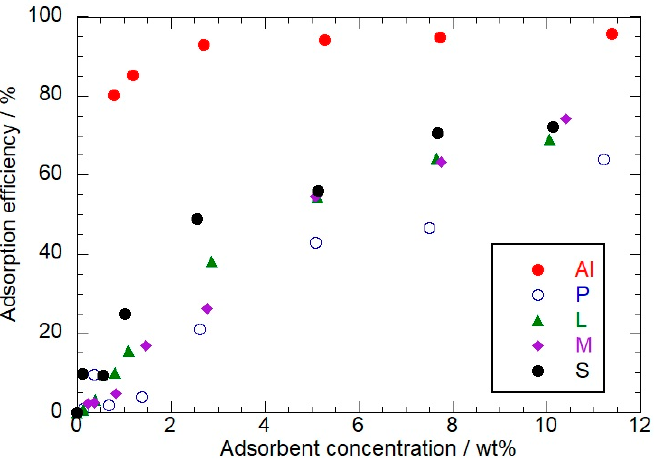
Figure 4. Percentages of flavonoids adsorbed as functions of the filler concentration.